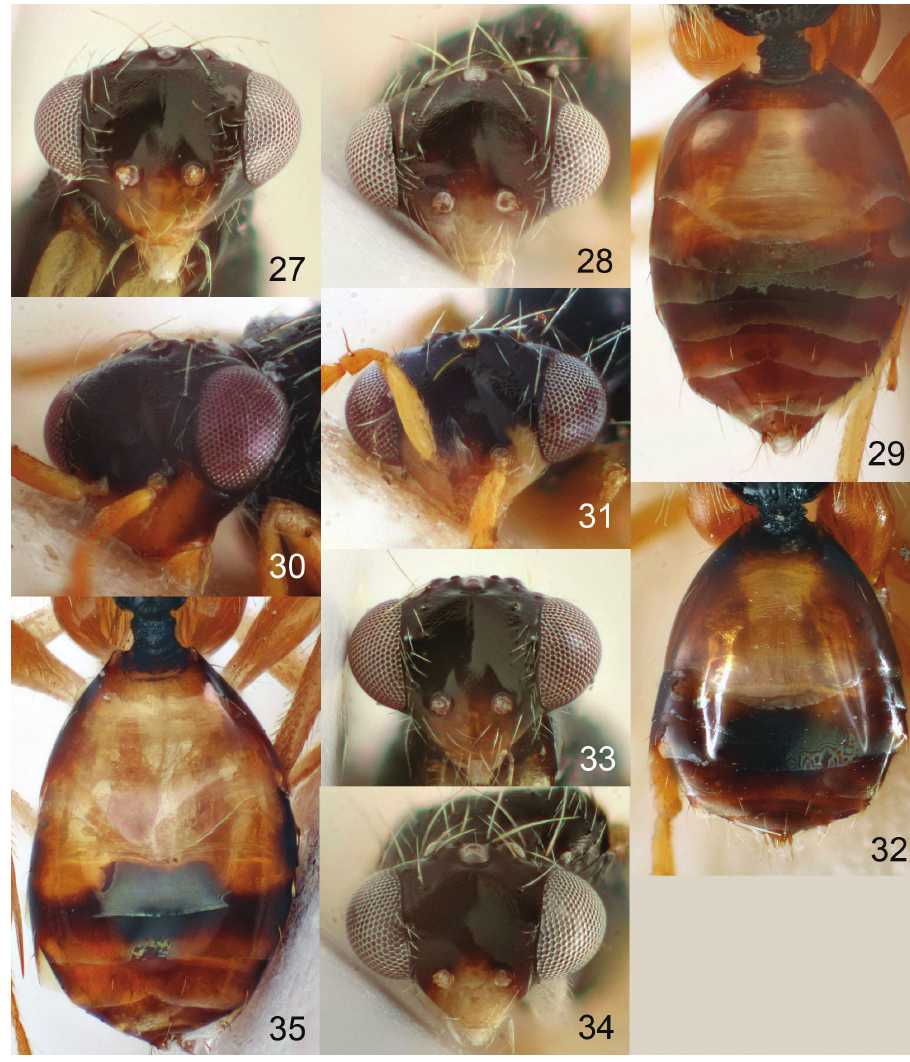
Figures 27–35. Euplectrus spp.: 27–29 E. intactus (Walker) 27 head frontal, female 28 head frontal, male 29 gaster dorsal, female 30–32 E. maculiventris Westwood 30 head frontal, female 31 head frontal, male 32 gaster dorsal, female 33–35 E. flavipes (Fonscolombe) 33 head frontal, female 34 head frontal, male 35 gaster dorsal, female.